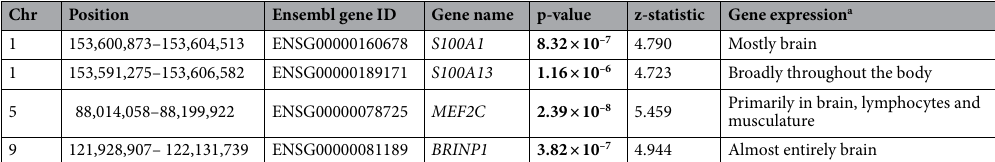
Table 1. Significant gene-level associations with science attainment scores. Position based on GRCh37. Bolded figures show significant associations (p < 2.80 × 10 −6 ) a Expression data examined using the GTEx portal on